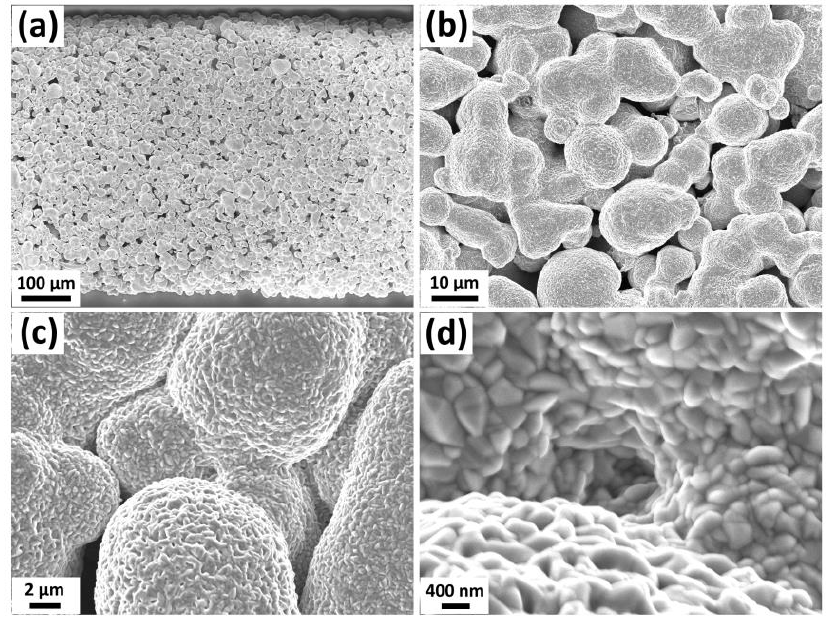
Figure 3. SEM images of the Al 2 O 3 /CuO-3D heterostructures after annealing at different scales: ( a ) 100 µm; ( b ) 10 µm; ( c ) 2 µm; and ( d ) 400 nm.